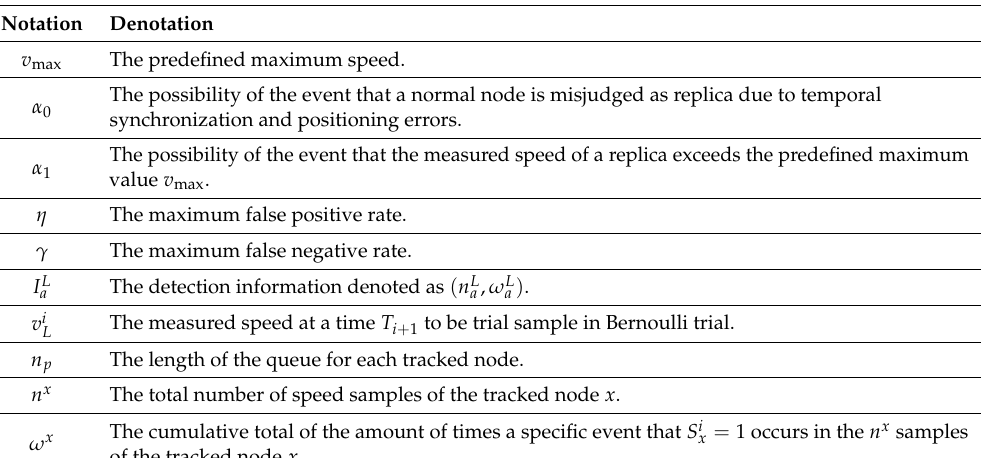
Table 2. Notations used in the proposed